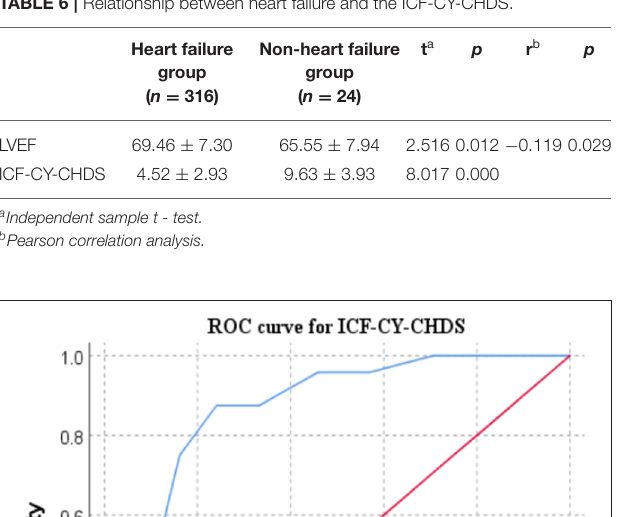
TABLE 6 | Relationship between heart failure and the ICF-CY-CHDS.